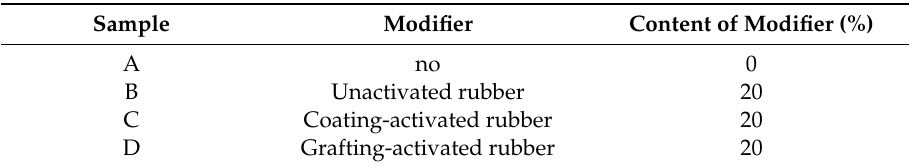
Table 3. Samples of asphalt